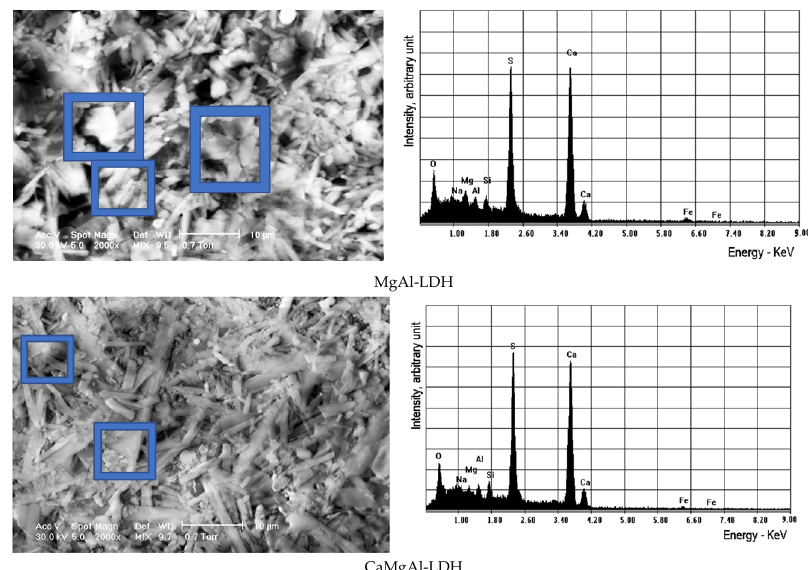
Figure 7. The SEM images for different magnifications of the samples treated with LDHs. Table 9. The EDS results of the investigated samples (C = control sample or